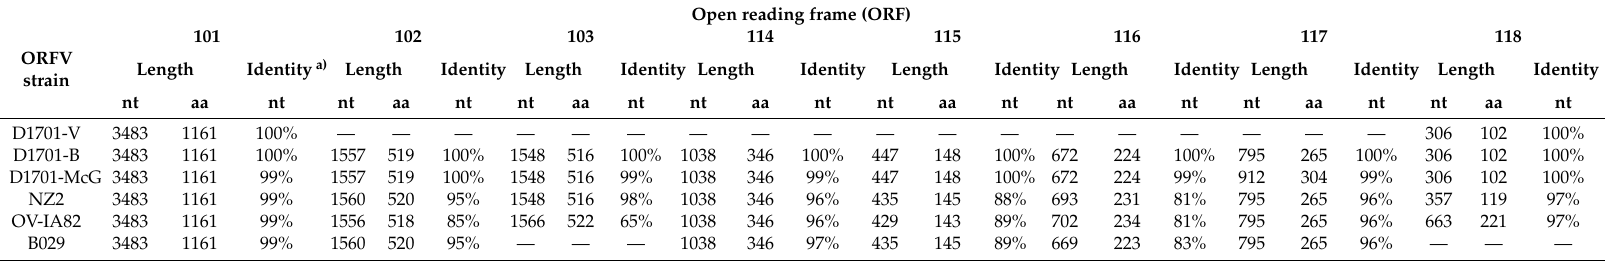
Table 2. Sequence comparison of genes of different ORFV strains located in the deletion loci AT and D. Sequence obtained from GenBank accession number